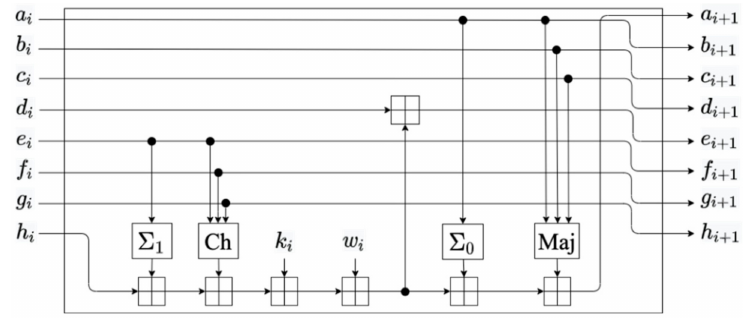
Figure 2. Round function of SHA-256 compression function.